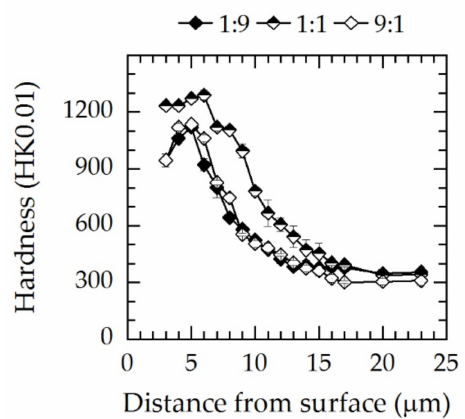
Figure 11. Microhardness–depth profiles for three di ff erent gas compositions at a screen power of approximately 5 kW; T = 733 K; t = 5 h. The lines are a guide for the